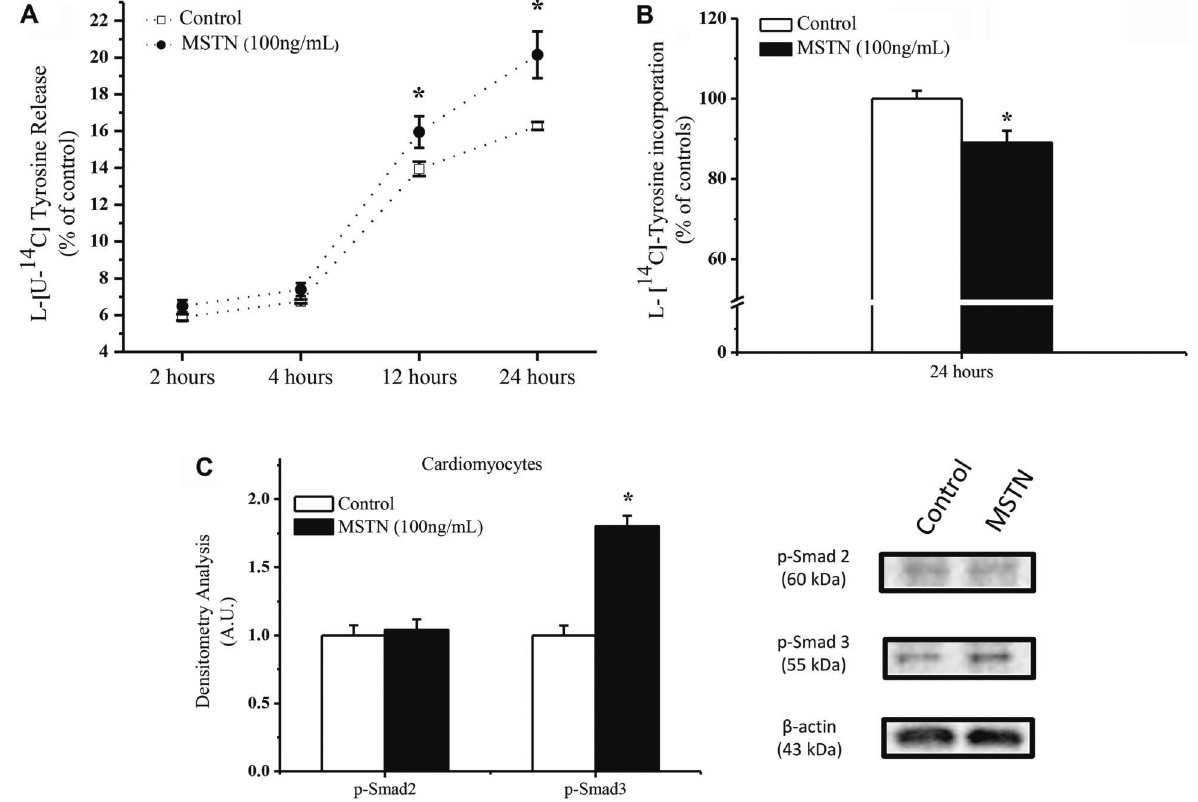
Figure 4. A , Overall proteolysis over time in cardiomyocytes incubated with myostatin (MSTN, 100 ng/mL). Data are reported as means ± SE of the percentage of labeled tyrosine related to the total amount of labeled tyrosine incorporated into proteins. Control was considered to be 100%, n=6. B , Rate of protein synthesis in cardiomyocytes after 24 h of incubation with myostatin (100 ng/mL). Data are reported as means ± SE of the percentage of tyrosine incorporated into total protein (n=7). Control was considered to be 100%. C , Phosphorylation status and densitometry analysis of Smad2 and Smad3 in cardiomyocytes incubated with myostatin for 4 h. Densitometry was corrected to b -actin. *P o 0.05 MSTN vs Control ( t